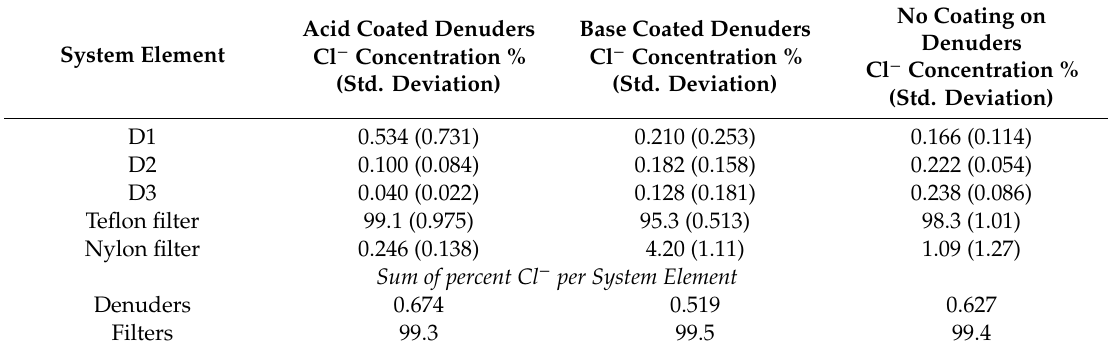
Table 1. Three-Denuder Set-up—Percent Cl − Concentrations. The values are given as the average percentage of the three trials conducted per coating treatment type (acid, base, or no coating) for a total of nine trials. The standard deviation is presented in brackets for each of the three coating